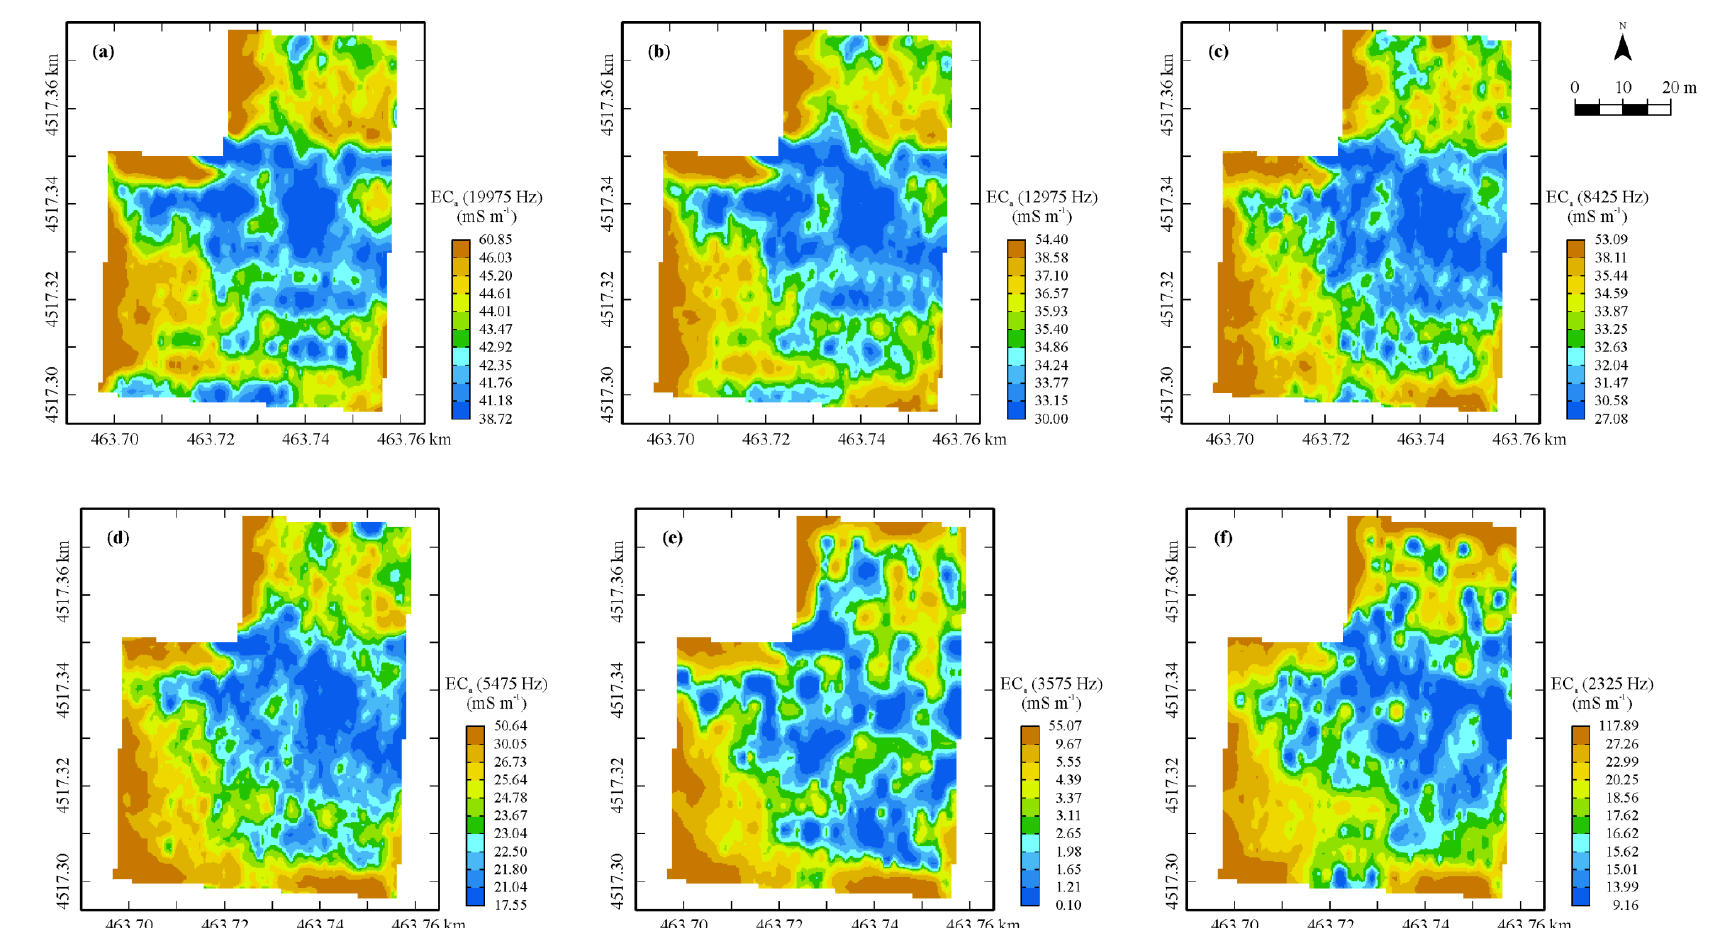
Figure 3. Maps of estimates of EC a (mS m −1 ) at the selected frequencies ( a - f ). Color scale uses iso-frequency classes.